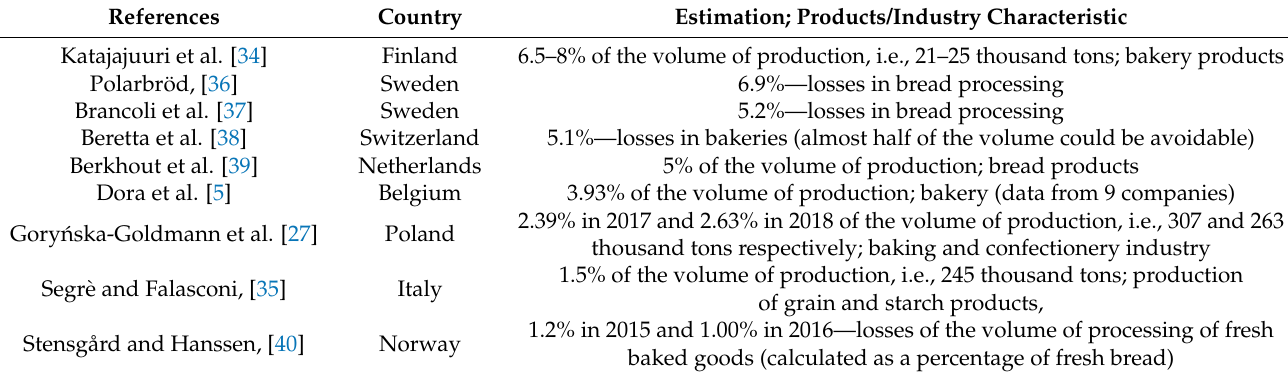
Table 1. Food losses in the baking industry in European countries, in descending order (based on available literature)